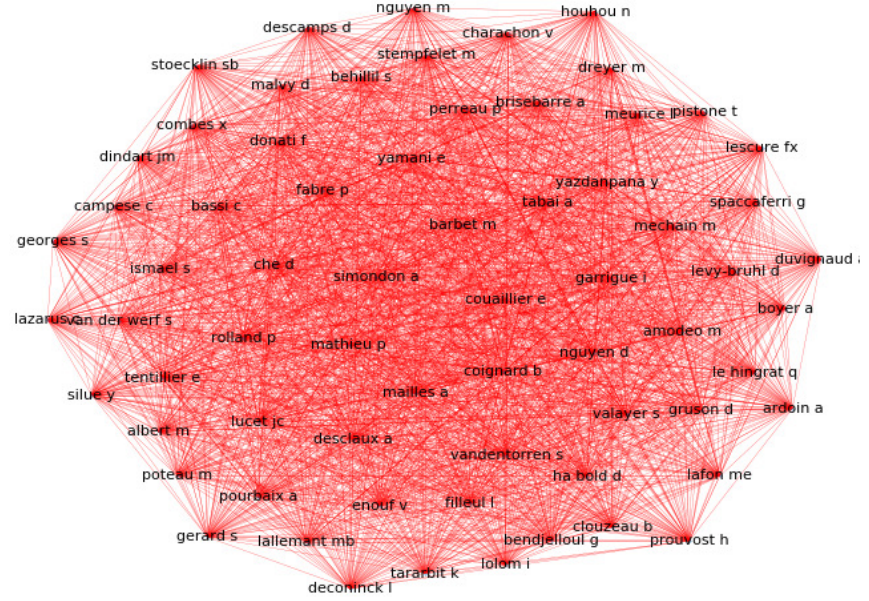
Figure 3. The most closely connected author community chart when the authors of all the articles in February are interconnected. The actual author’s name is marked on each point, and the red edge is used to connect the points in the